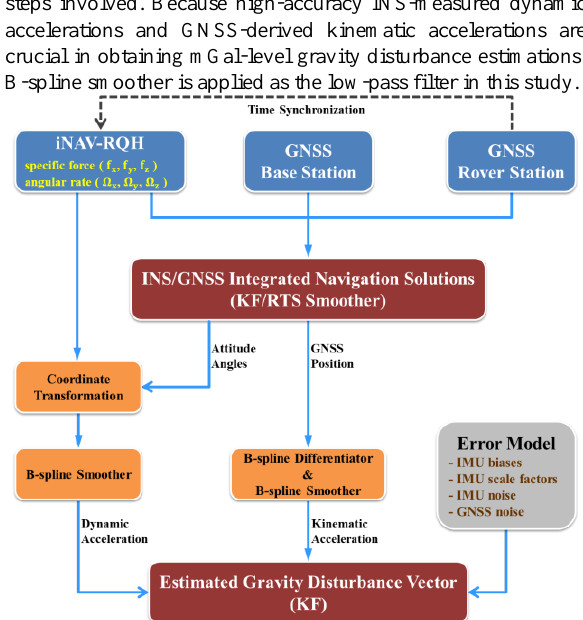
Figure 4. The determination flowchart of INS/GNSS gravimetry First, the tightly-coupled integration of iNAV-RQH and GNSS measurements is processed by using RTS smoother. The optimal results of GNSS positions and attitude angles are obtained for further processing. Second, the kinematic accelerations are computed using the GNSS positions by applying a fifth-order B-spline differentiator. A third-order B- spline smoother with a window length of 60 seconds is adopted to remove high-frequency noises. The raw data of accelerometers from iNAV-RQH contain gravity and vehicle accelerations. The INS-measured dynamic accelerations are also processed by the same third-order B-spline smoother for consistency. Finally, the INS systematic errors are estimated and subsequently removed by the Kalman filter for estimating the gravity disturbance